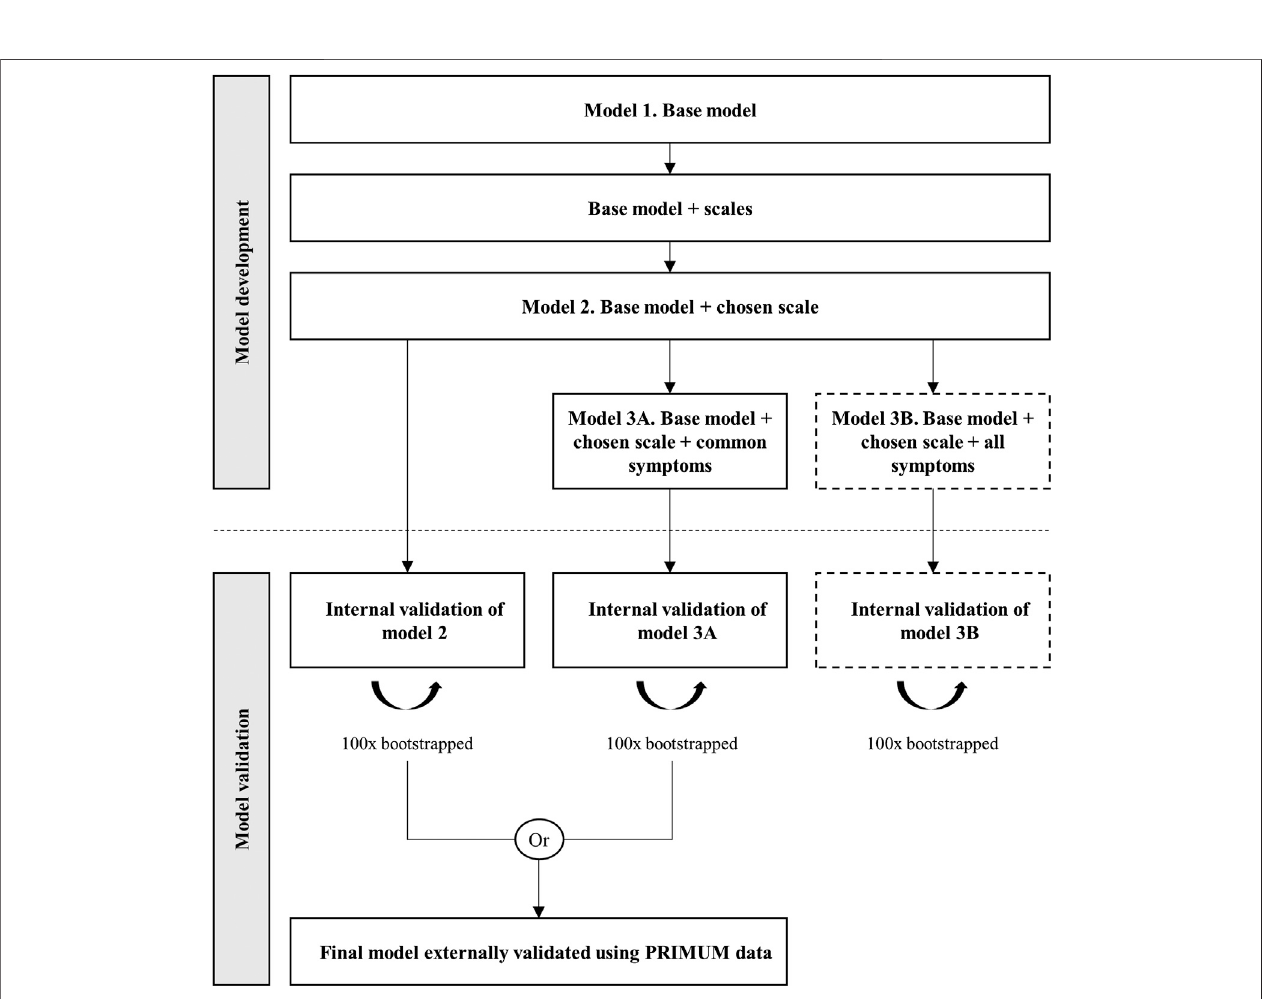
FIGURE 1 | Model development and validation